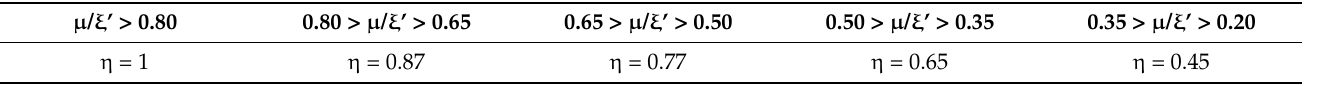
Table 1. Approximate values of η to use in lieu of the analytical exact values. The approximate η are expressed as a function of the µ / ξ ’